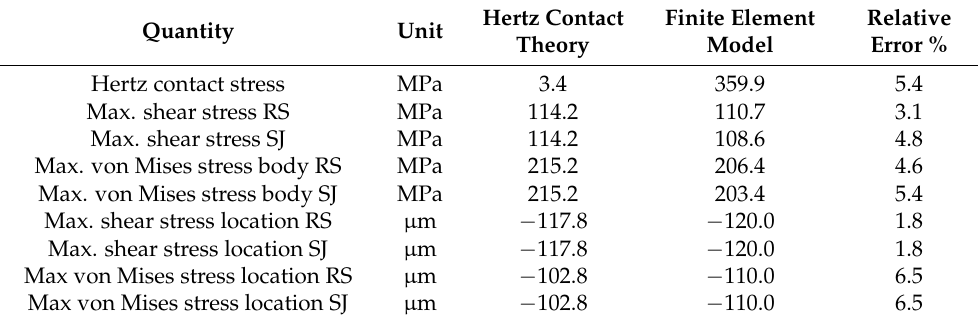
Table 1. Summary of the results of calculations of the maximum stresses and the depth of their occurrence for the shaft journal (SJ) and the steel roller support (RS), under a reaction force of R = 1253 N.